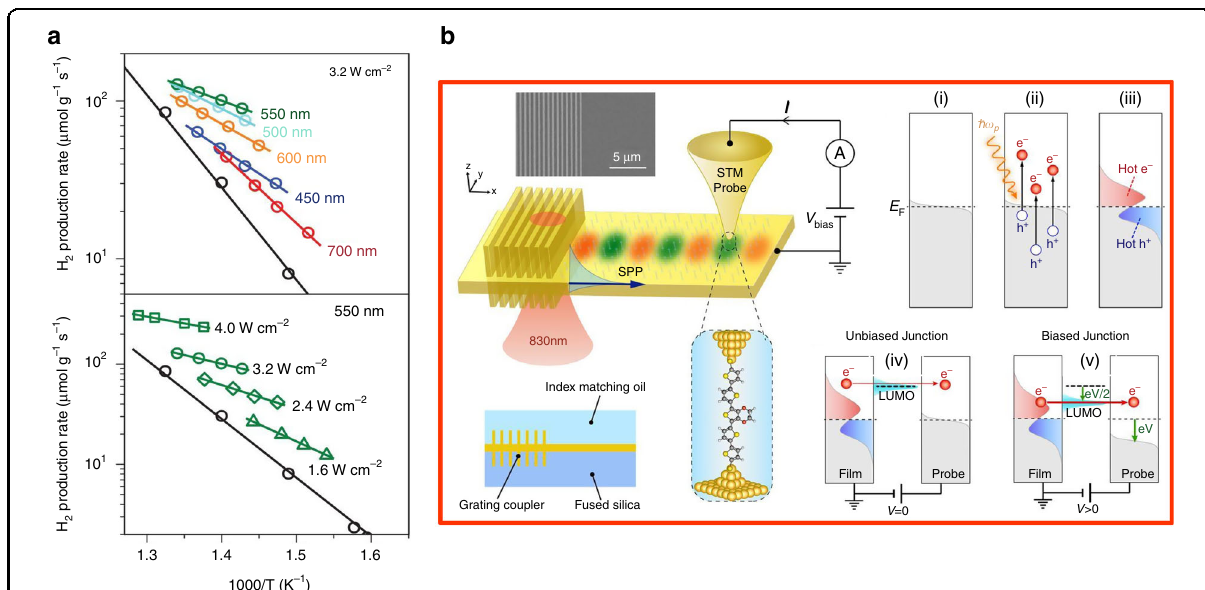
Fig. 19 The effect of HC in photoinduced plasmonic chemical reactions. a The quanti fi cation analysis of reaction mechanism with and without HC generation in terms of light intensity and wavelength in hydrogen production and b the schematics of the experiment where a single-molecule junction was established between a grounded nanodevice and the STM probe, alongside the HC generation and their distribution. The fi gures are taken with permission from ( a ) ref. 112 and ( b ) ref.